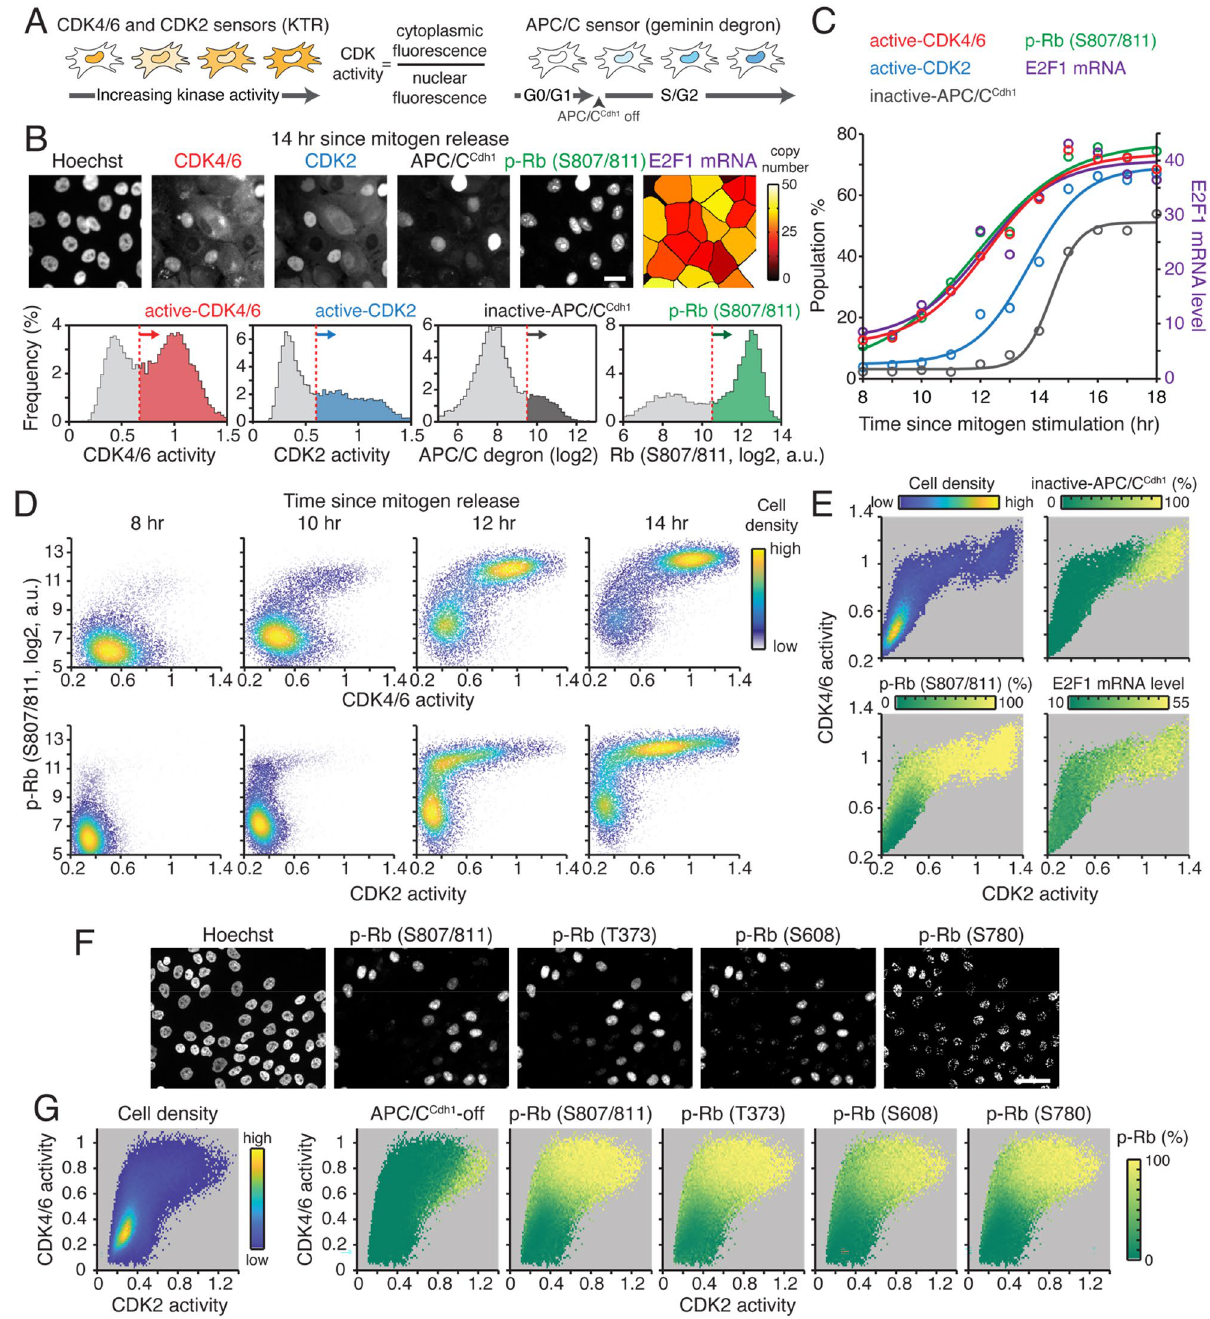
Figure 1. CDK4/6 activation is tightly coupled with Rb phosphorylation and E2F1 mRNA induction. ( A ) Schematics of CDK4/6, CDK2 (left), and APC/C Cdh1 (right) reporter. Active CDK4/6 and CDK2 phosphorylate and induce translocation of reporters to the cytoplasm. As APC/C Cdh1 is inactivated, intensity of the reporter starts increasing. ( B ) Top, representative images of CDK4/6, CDK2, and APC/C Cdh1 reporters, phosphorylation of Rb (p-Rb, S807/811) immunostaining, and mRNA FISH for E2F1 mRNA in the same MCF-10A cells. Scale bar is 20 µm. Bottom, histograms of CDK4/6, CDK2, and APC/C Cdh1 activities and p-Rb at S807/811. Red dotted line indicates a threshold used to classify active CDK4/6 and CDK2, inactive APC/C Cdh1 , and p-Rb populations. After 48 h mitogen removal, cells were stimulated with mitogens for 14 h prior to fixation. ( C ) Scatter plot of the percentage of cells with active CDK4/6 and CDK2, inactive APC/C Cdh1 , p-Rb at S807/811, and averaged E2F1 mRNA levels in MCF-10A cells as a function of time after mitogen stimulation. Solid line represents sigmoidal best-fit line. ( D ) Single-cell correlation of p-Rb at S807/811 versus CDK 4/6 activity (top) and CDK2 activity (bottom) in MCF-10A cells at various time points after mitogen stimulation (8, 10, 12 and 14 h). Cell density is color-coded. ( E ) Three-dimensional activity map of CDK4/6 versus CDK2 activity in MCF-10A cells where cell density, the percentage of inactivated APC/C Cdh1 , the percentage of p-Rb at S807/811, and E2F1 mRNA levels are color-coded. ( F , G ) Representative images of multiplexed staining for p-Rb (S807/811, T373, S608, S780) in MCF-10A cells ( F ). Scale bar is 20 µm. Three-dimensional activity map of CDK4/6 versus CDK2 activity where cell density, the percentage of inactivated APC/C Cdh1 , and the percentage of p-Rb at S807/811, T373, S608, or S780 are color-coded ( G ). After 48 h mitogen removal, MCF-10A cells were stimulated with mitogens for 12 h prior to